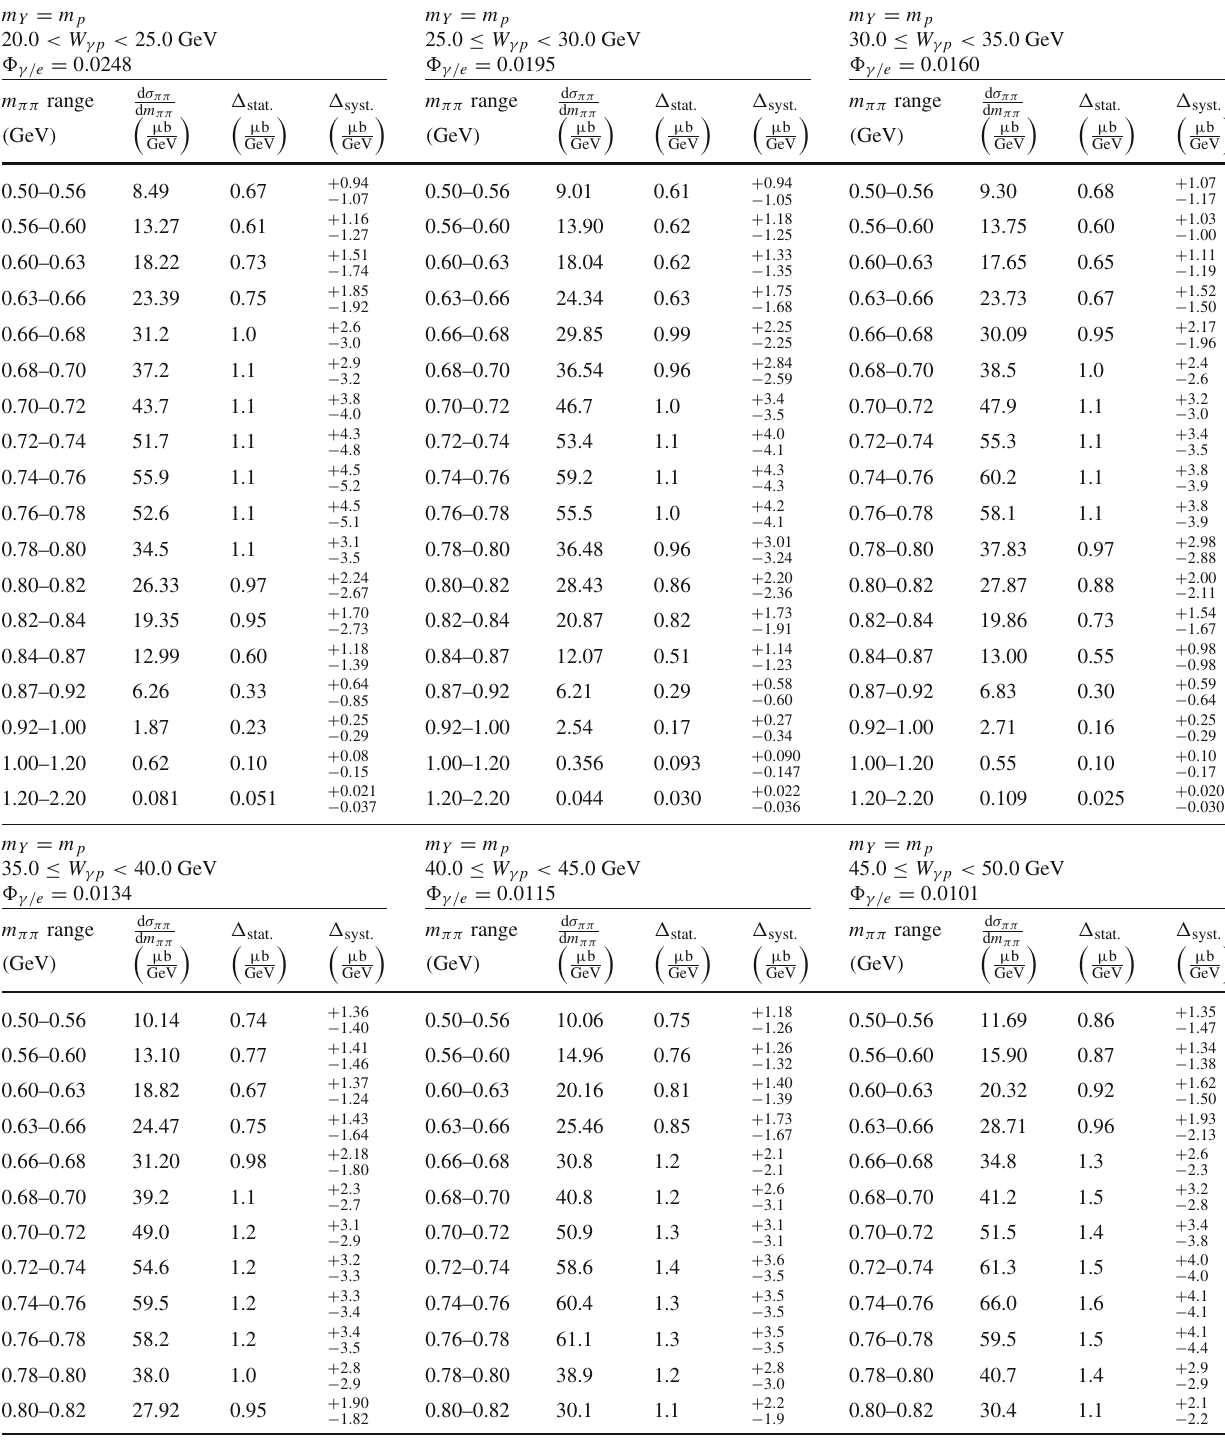
Table 18 Unfolded elastic ( m Y = m p ) differential π + π −